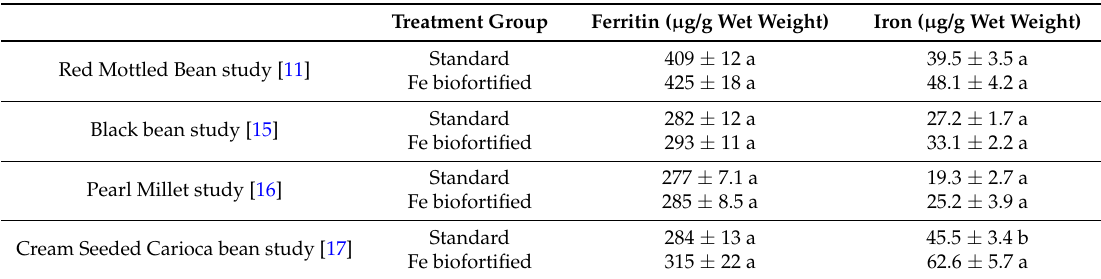
Table 6. Ferritin protein and the iron concentration in the liver 1